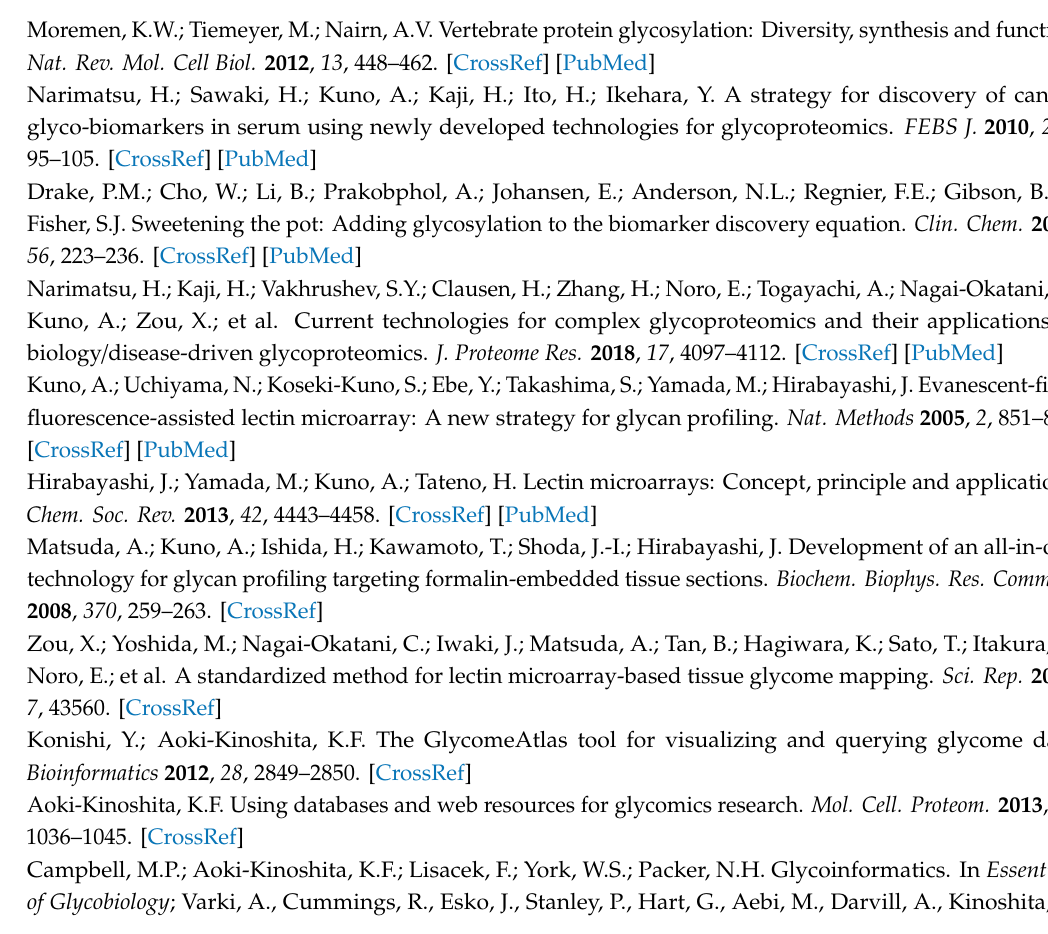
Supplementary Materials: The following are available online, Table S1: Abbreviations and carbohydrate specificities of 45 lectins on